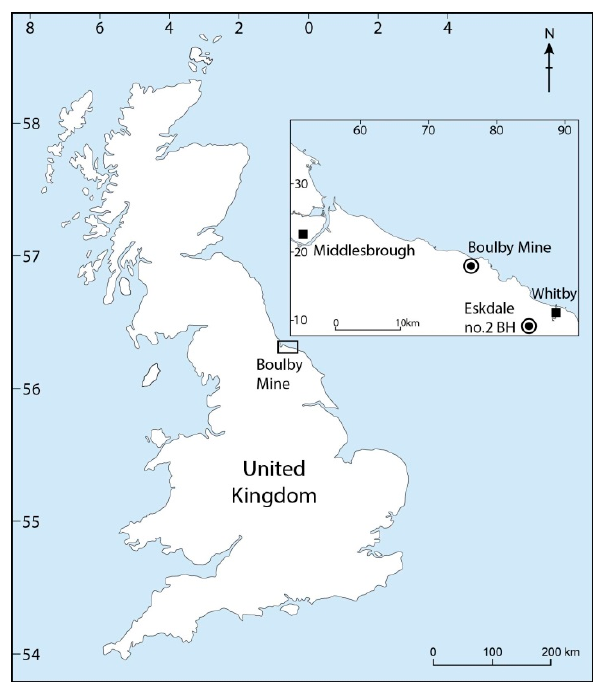
Figure 2. Map showing sample localities at Boulby potash mine and Eskdale No. 2